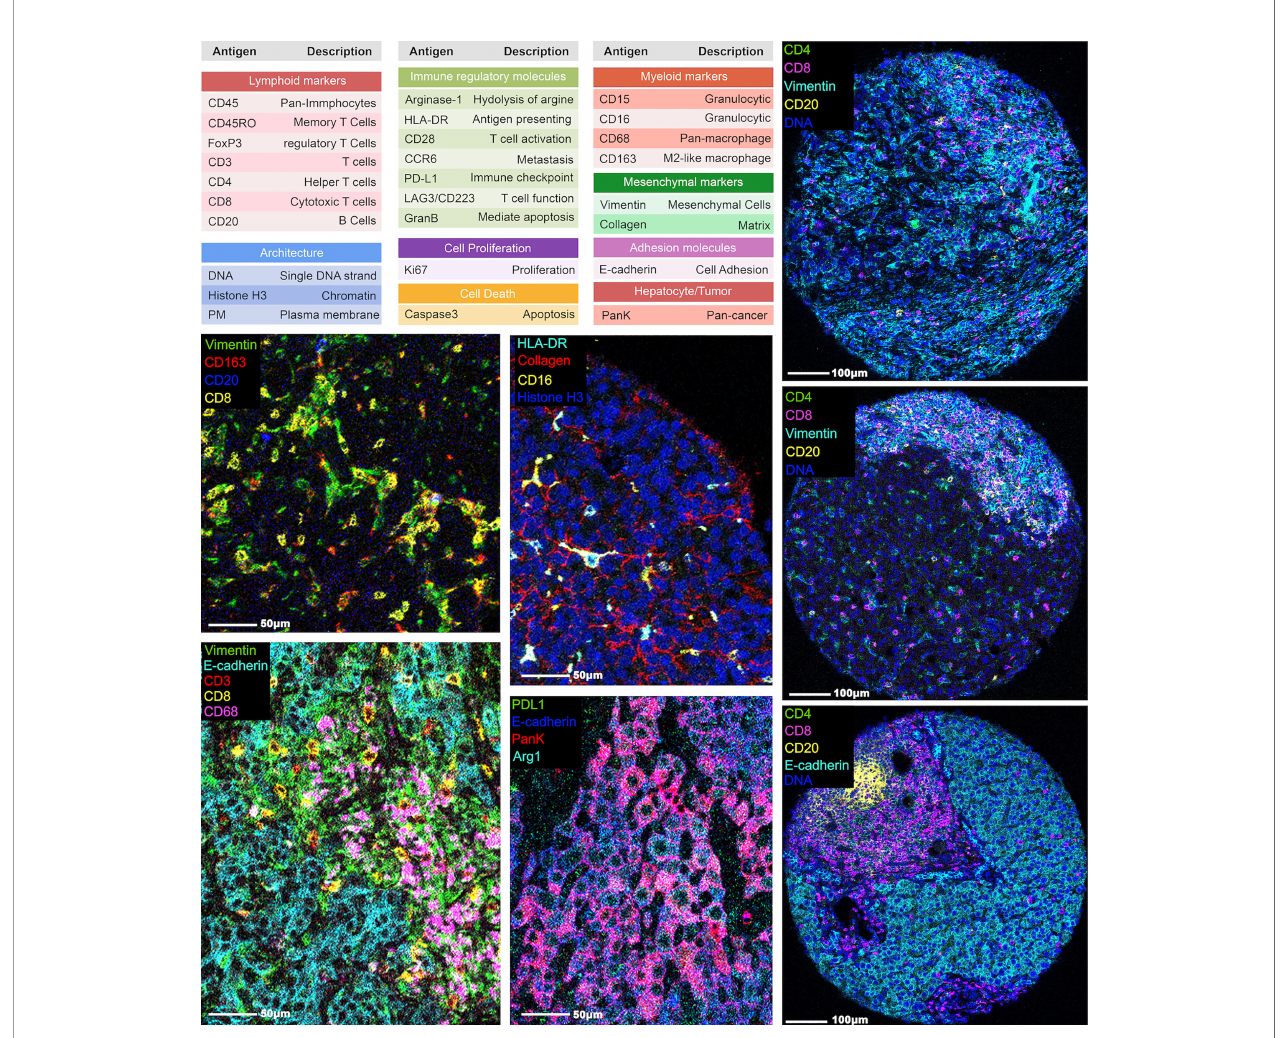
FIGURE 1 | Representative images from IMC. A panel of 27 markers was used to stain the hepatocellular carcinoma tumor region cores and processed using IMC. The marker names and descriptions are